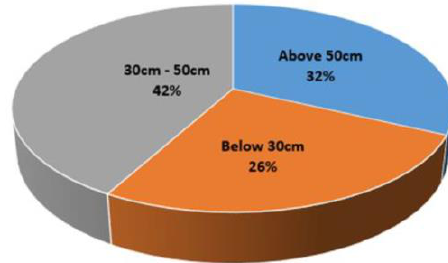
Figure 7. Percentage of trees according to the DBH measurement of trees at the TM Resort